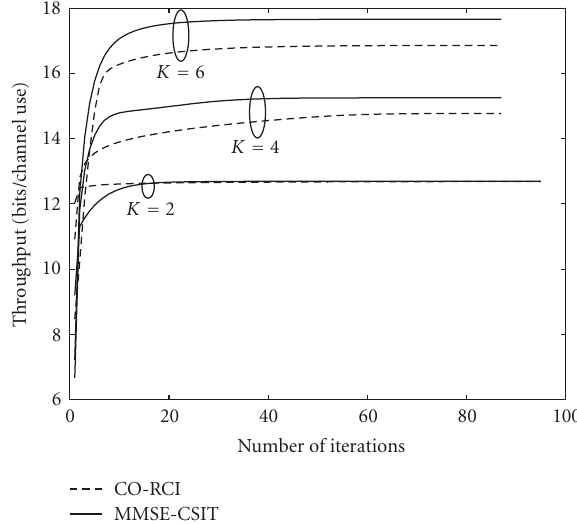
Figure 4: Convergence of CO-RCI and MMSE-CSIT beamforming algorithms for N t = 4, N r = 4, P = 10, and di ff erent number of users for a channel realization from the measured